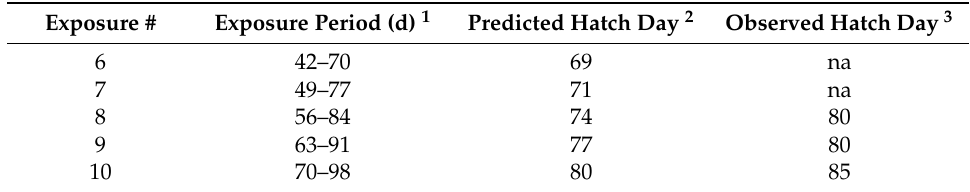
Figure 5. Each solid line illustrates the daily progression of developmental age during a 28 d exposure to ( a ) 5 °C and ( b ) 15 °C calculated with the Salis model (Equation (8)). The dotted line designates the age threshold ( A = 0.46) above which the Salis model rates decrease (5 °C) or increase (15 °C), and A = 1 (hatch). Table 1. Comparison of the hatch day predicted by the Salis model and experimentally observed in the 15 °C treatments.